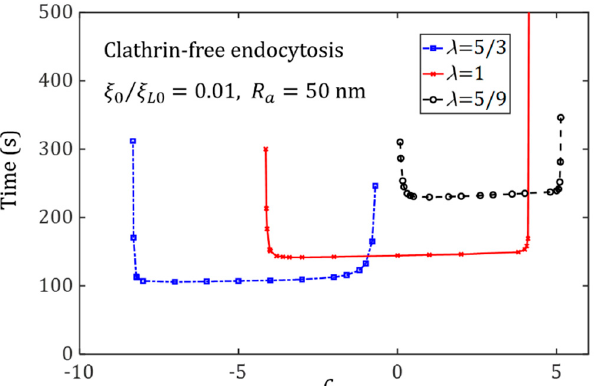
Figure 3. In the cellular uptake of NPs with R a = 50 nm via membrane-mediated endocytosis, wrapping time as a function of the degree of non-uniformity of ligand distribution, c , for ξ 0 = 0.01 ξ L 0 and different ratios λ = 5/3, 1 and 5/9.